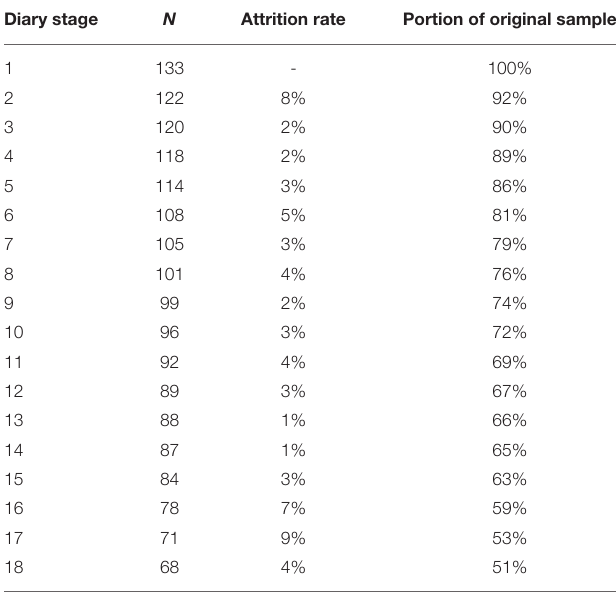
TABLE 1 | Attrition rate for each diary stage respective to each previous diary stage, including the corresponding portion of the initial diary survey